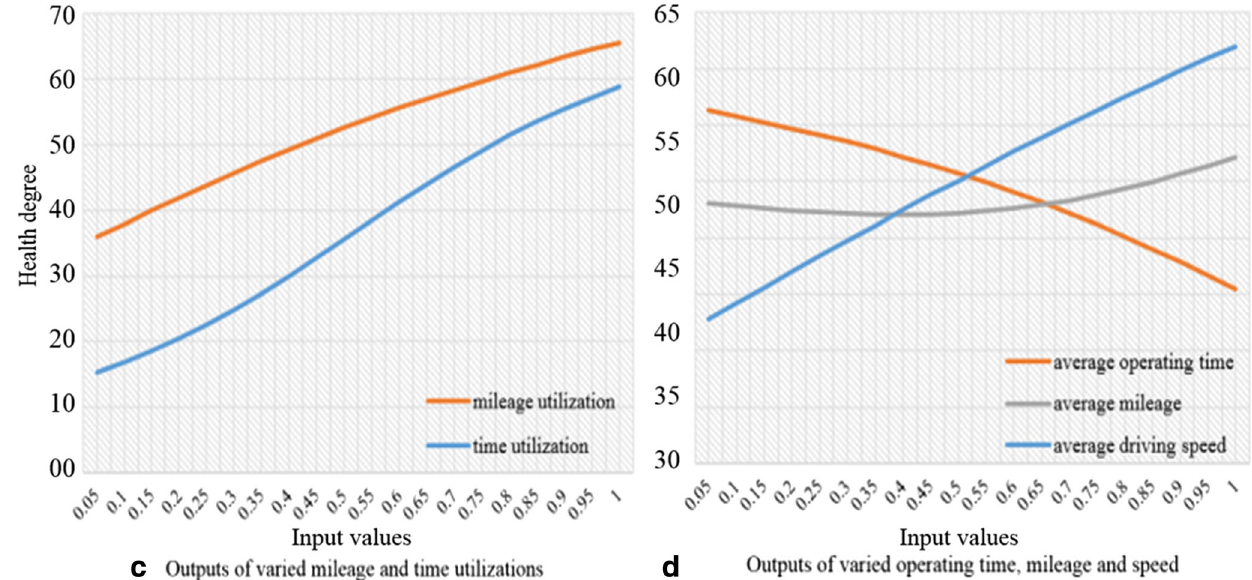
Fig. 10 Outputs of varied input of productivity